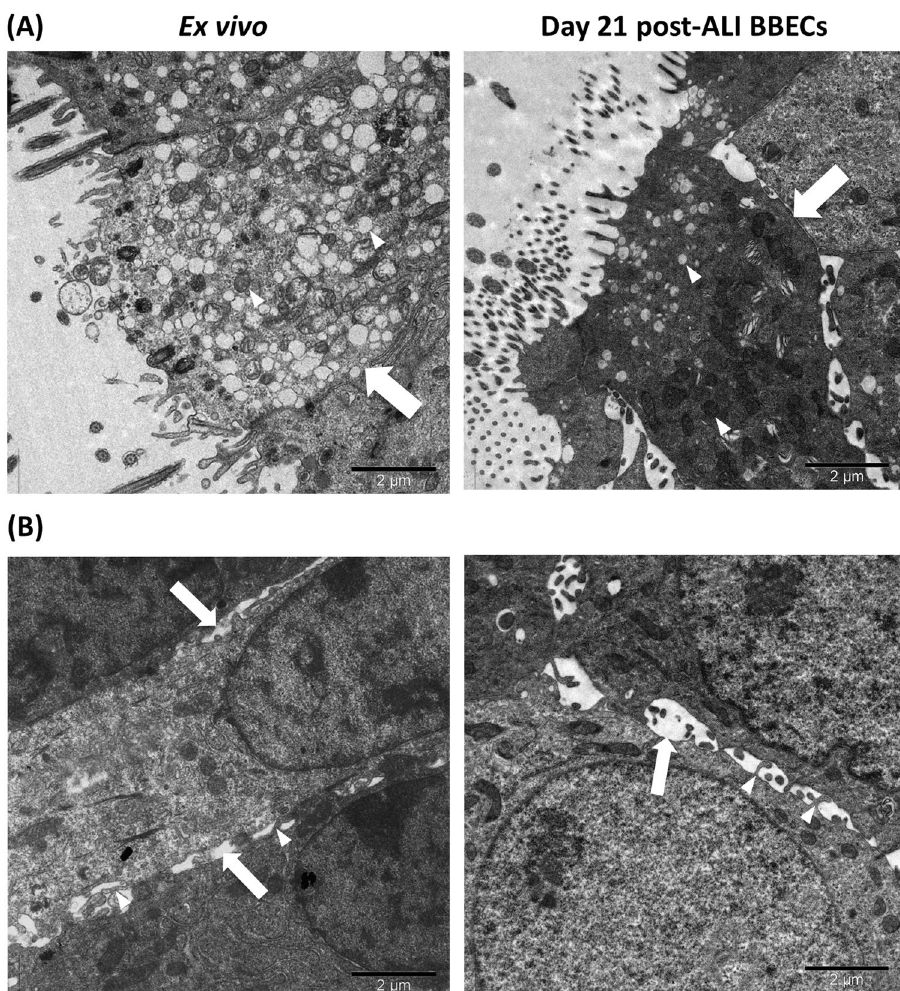
Figure 8. Ultra-structural comparison of goblet cells and paracellular spaces in ex vivo bronchial epithelium and differentiated BBECs using TEM. Ex vivo bronchial epithelium and day 21 post-ALI BBEC cultures were fixed and resin embedded, and ultrathin sections were cut and contrast stained. Images highlight ( A ) goblet cells (arrows) containing numerous secretory vesicles (arrowheads) and ( B ) paracellular spaces (arrows) containing membranous interdigitations